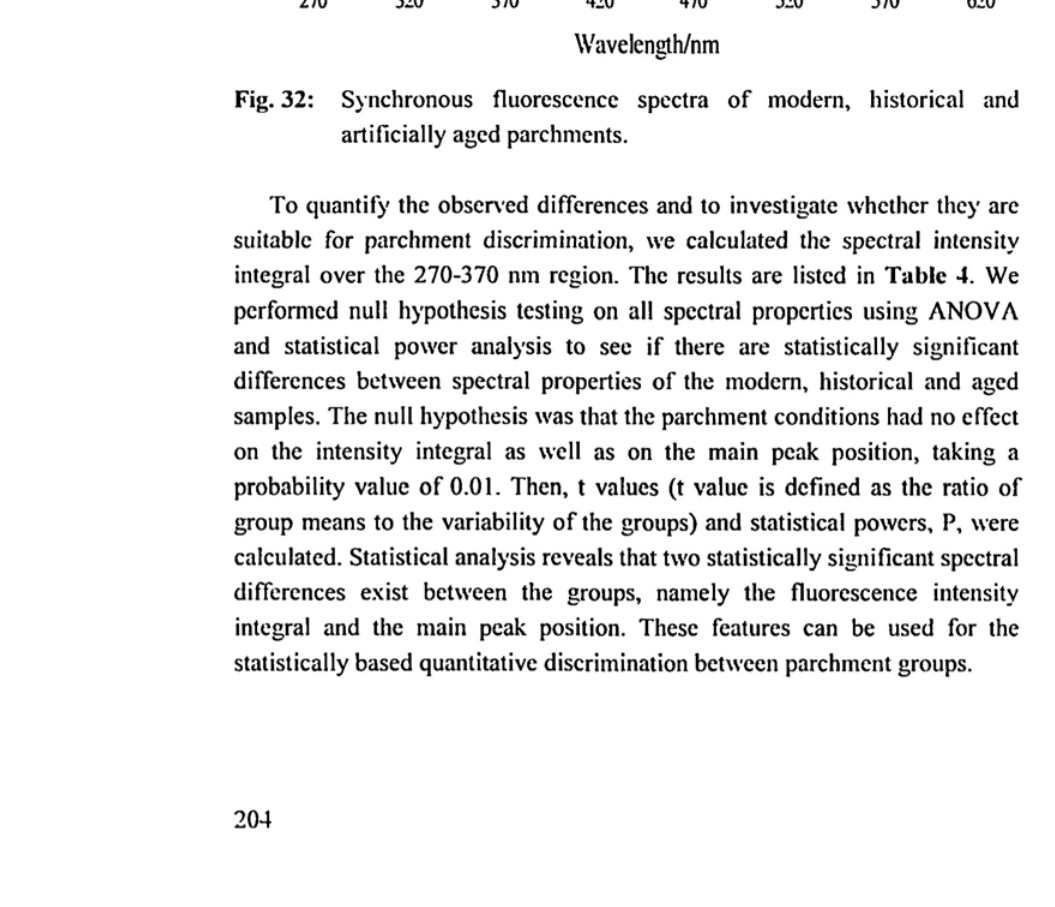
Fig. 32: Synchronous fluorescence spectra of modern, historical and artificially aged